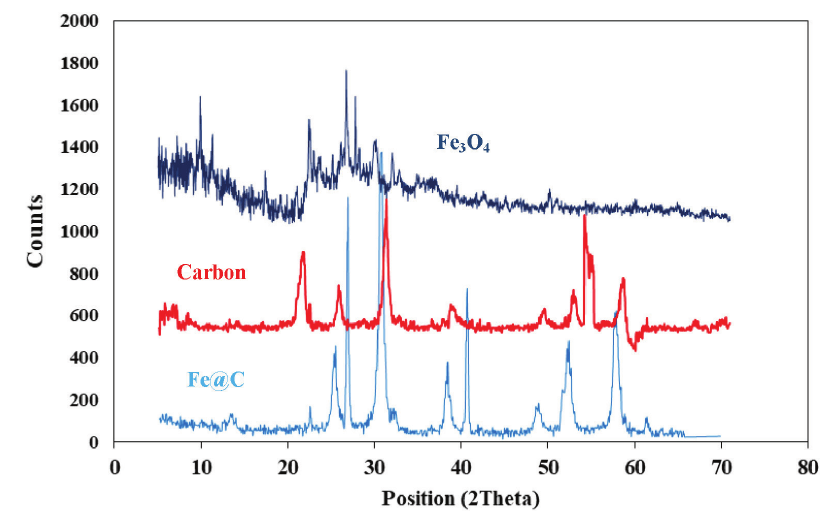
Fig. 3 – XRD patterns of Fe